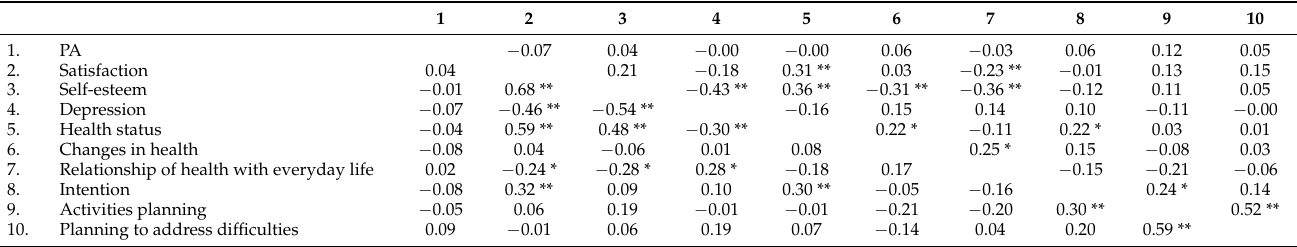
Table 3. Correlations between variables for the first and second measurement in the total sample. Scores above the diagonal represent the correlations for the first measurement. Scores below the diagonal represent the scores for the second measurement.